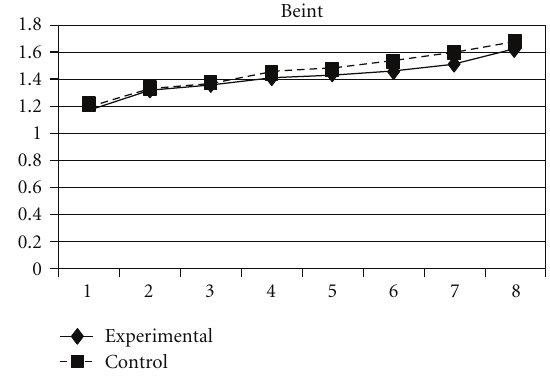
Figure 12: Growth trajectories of the experimental group (all par- ticipants) and control group using the item score of ecstasy use as the outcome indicator.